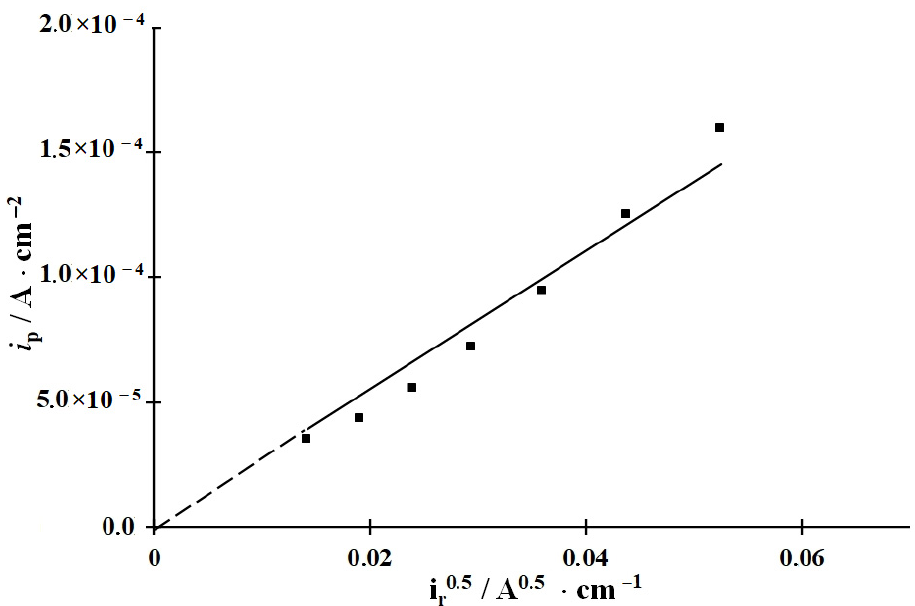
Figure 4. Plot of the current of hydrogen penetration through the membrane vs. the rate of its chemical recombination in 2 M HCl.